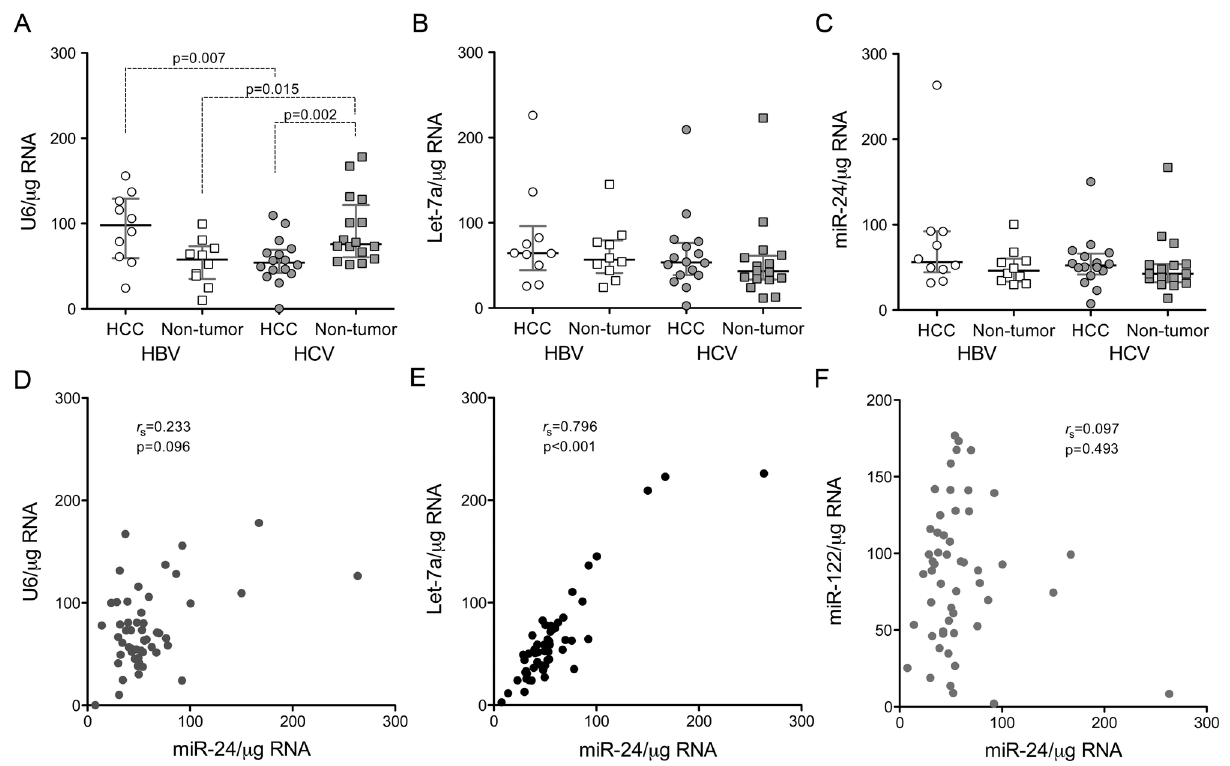
Figure 3. Comparison of small RNAs as normalizers for assessing miR-122 abundance. Shown in the panels at the top are the relative abundance of ( A ) U6 snRNA, ( B ) Let-7a, and ( C ) miR-24 miRNAs in paired tumor and non-tumor tissues from subjects with HBV or HCV infection, normalized to total RNA. Bars represent median and quartiles for each group. Statistical comparisons between groups were made with paired or unpaired t tests, and are shown only if p<.05. In the lower set of panels, ( D ) U6, ( E ) Let-7a, and ( F ) miR-122 abundance are plotted as a function of miR-24 abundance. r